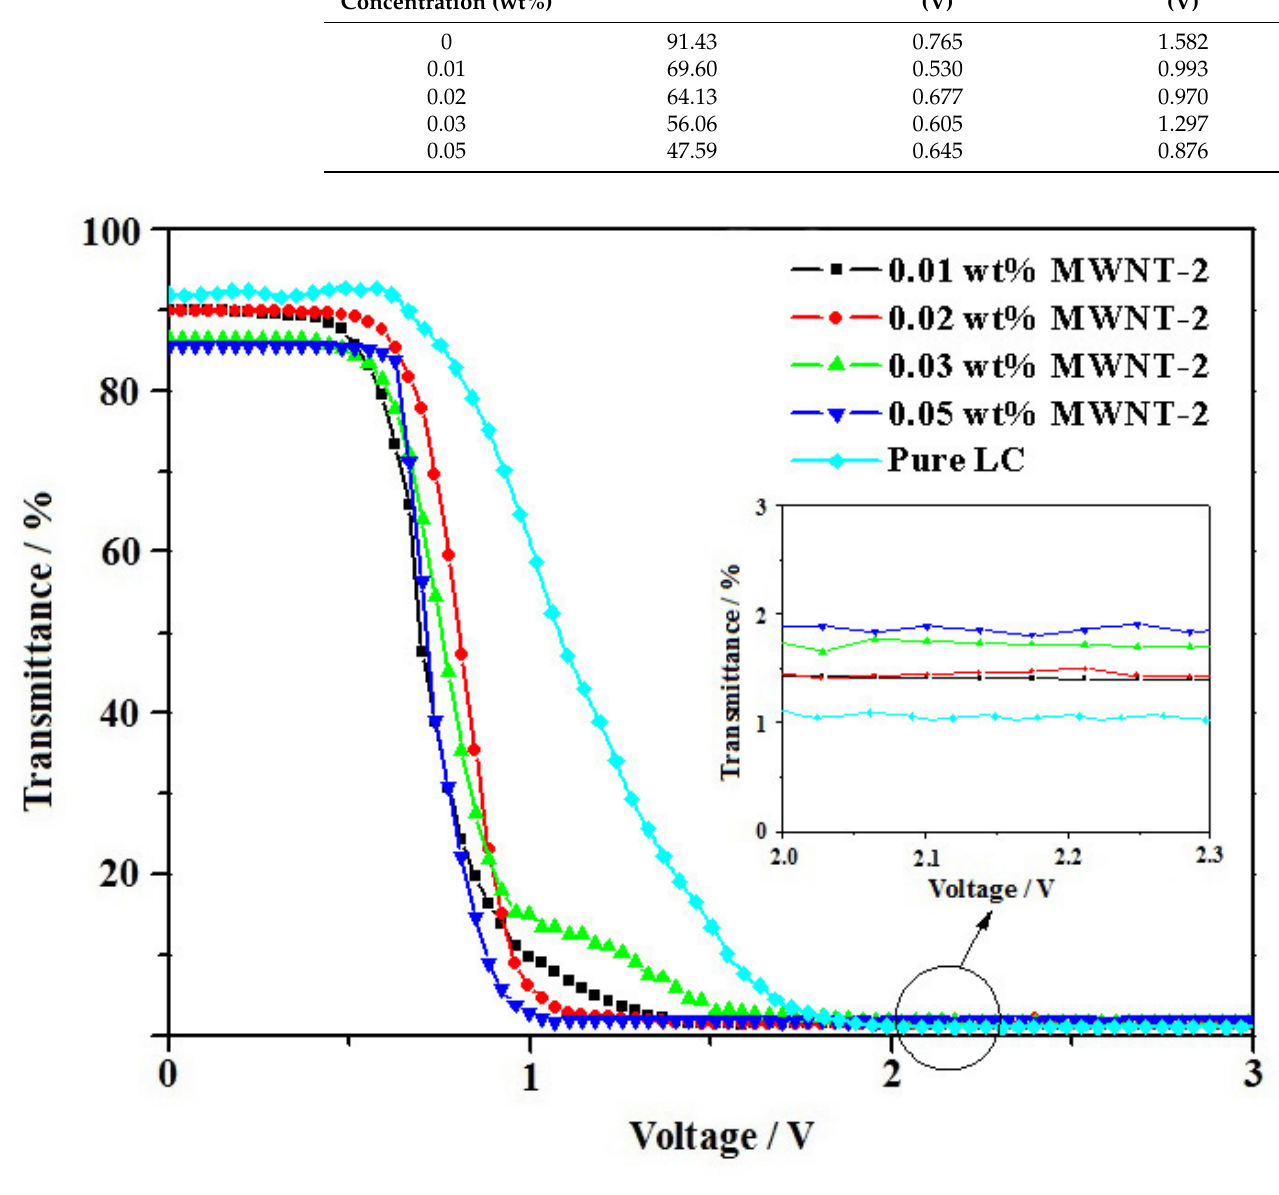
Figure 4. The voltage dependence of the transmittance curves of the TN cells with different concen- trations of MWNT-2 doping.